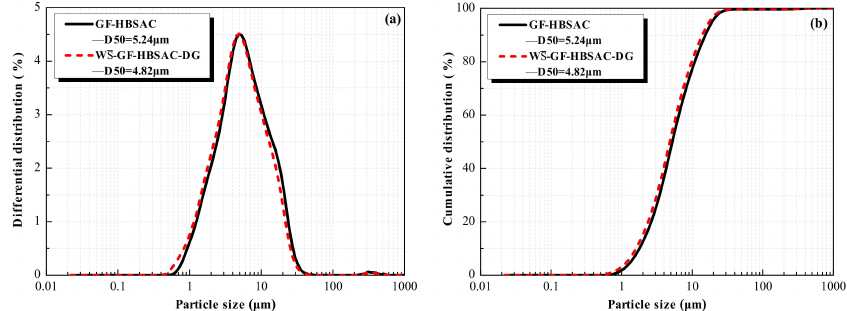
Figure 12. Particle size distribution curves of the Series GF-HBSAC-X cement: ( a ) Di ff erential distribution; ( b ) cumulative